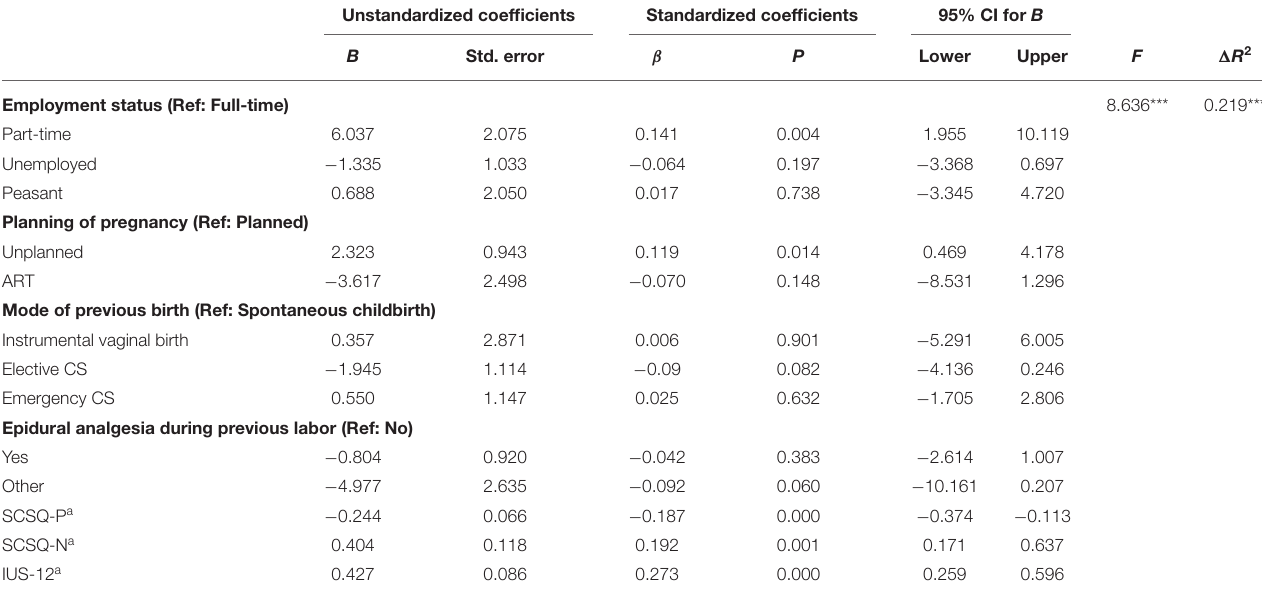
TABLE 6 | Results of linear regression for predicting FOC of multiparous women ( N = 615). Unstandardized